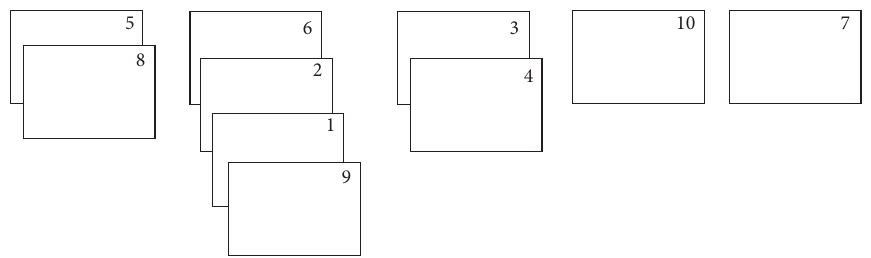
Figure 2: Hypothetical sorting exercise. Participants group statements into different piles based on similarities.